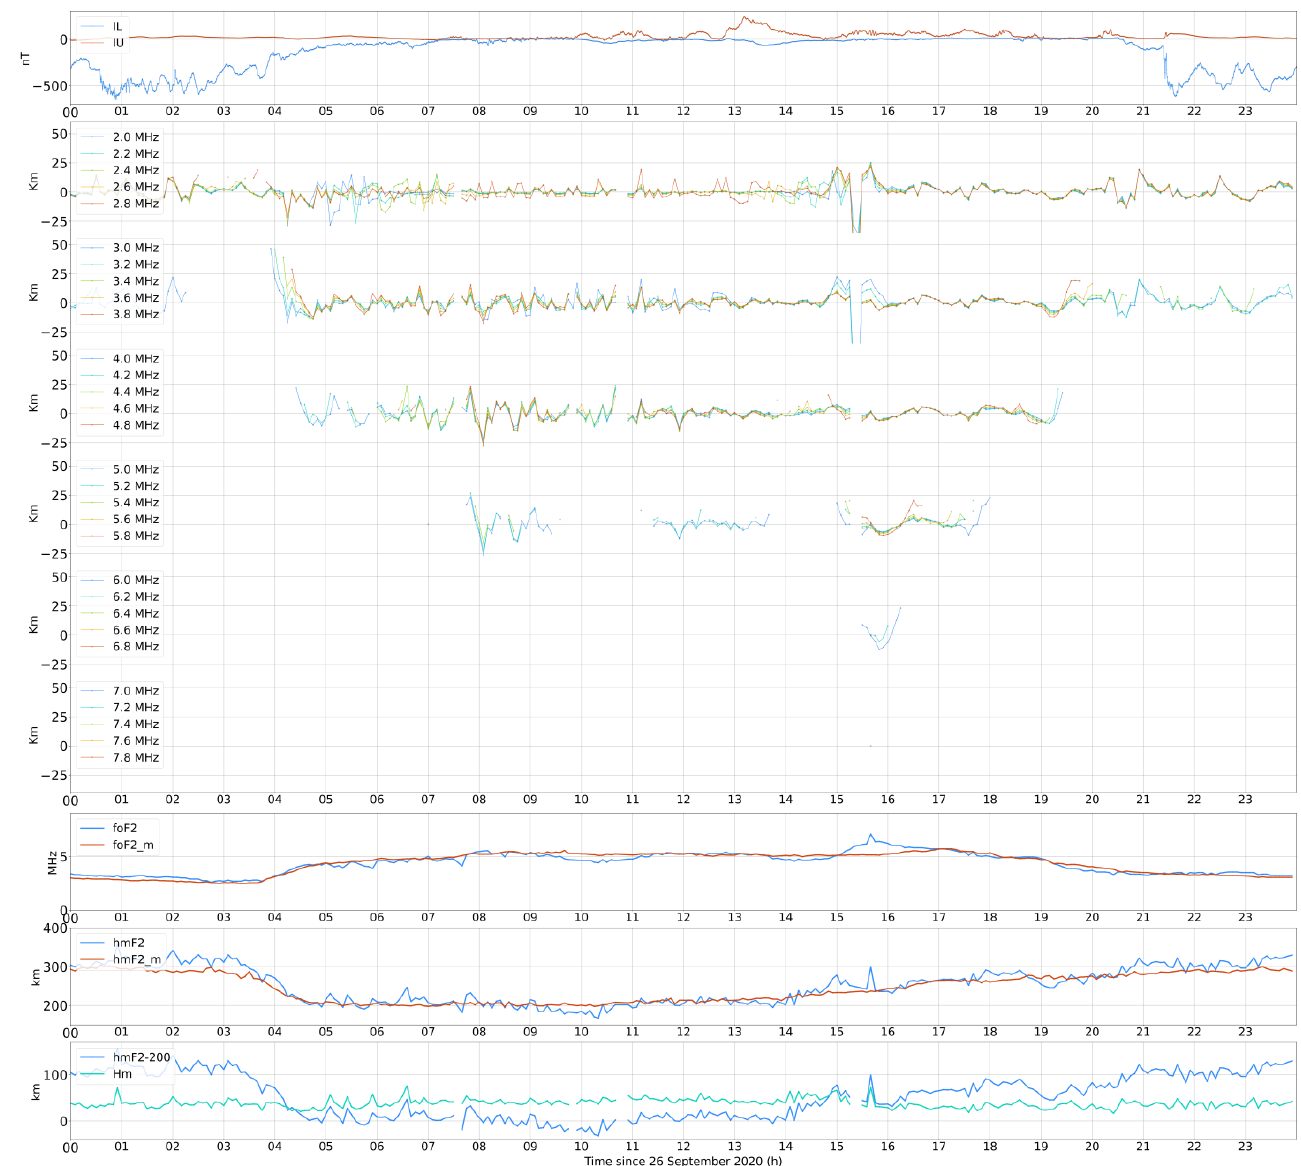
Figure 3. Same as Figure 2 for 26 September 2020.